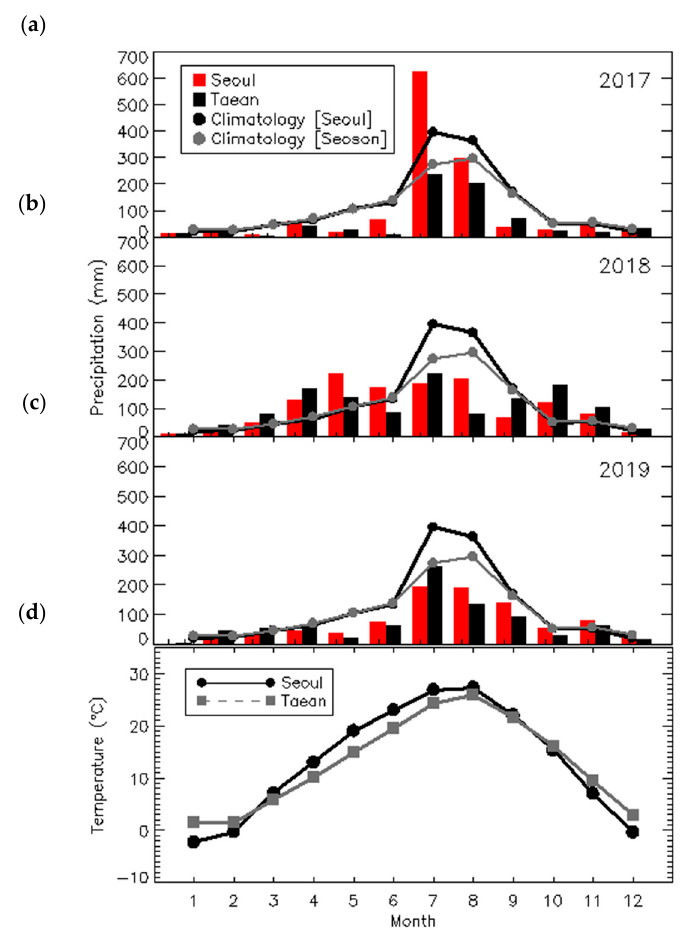
Figure 4. Monthly precipitation in Seoul (red bar) and in Taean (black bar) for ( a ) 2017, ( b ) 2018, and ( c ) 2019. Black and gray lines represent monthly climatology of precipitation during 30-years (1981–2010) at Seoul (black dot-line) and Seosan (gray dot-line), respectively. ( d ) The monthly temperature averaged during the period of 2017–2019 in Seoul (black dot-line) and Taean (gray square-line).